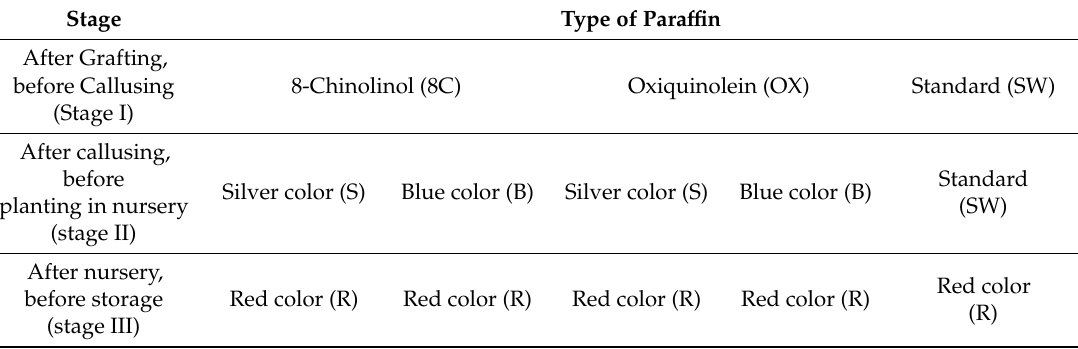
Figure 1. Experimental design. Note: VA: forest ground 50% + red peat 30% + river sand 15% + conifer sawdust 5%; VB: forest ground 60% + black peat 25% + river sand 10% + conifer sawdust 5%; VC: forest ground 70% + river sand 15% + conifer sawdust 15%. Table 1. Used para ffi n in three stages and experimental